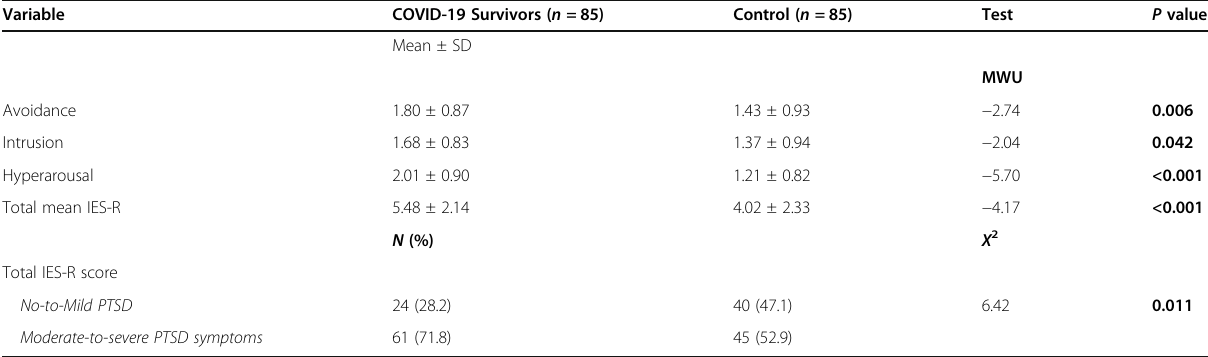
Table 2 PTSD symptoms among COVID-19 survivors and control subjects Variable